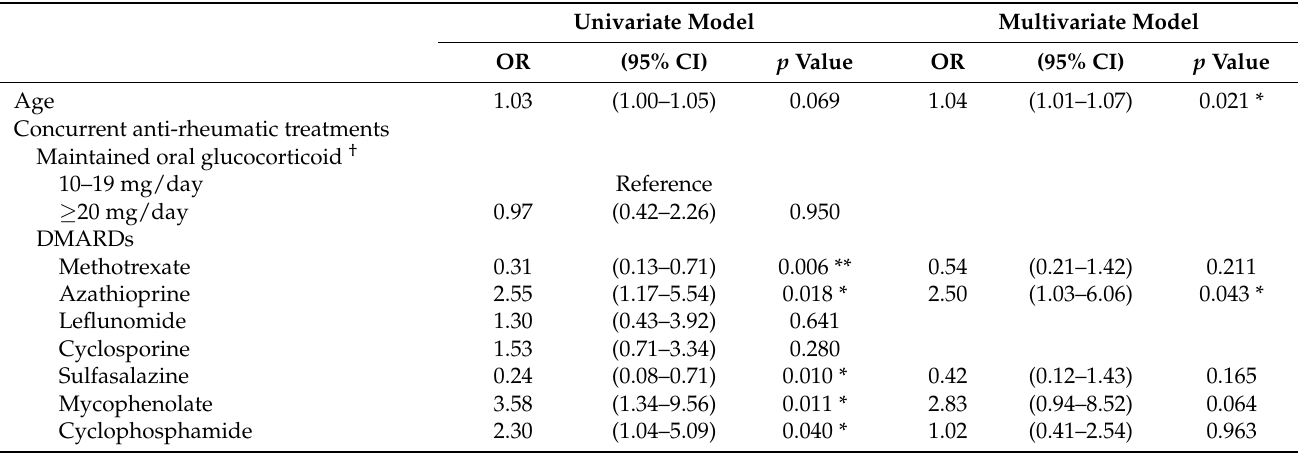
Table 3. Risk factors associated with hepatitis after receiving glucocorticoid pulse therapy in HBsAg-negative, anti-HBc- positive rheumatic patients.